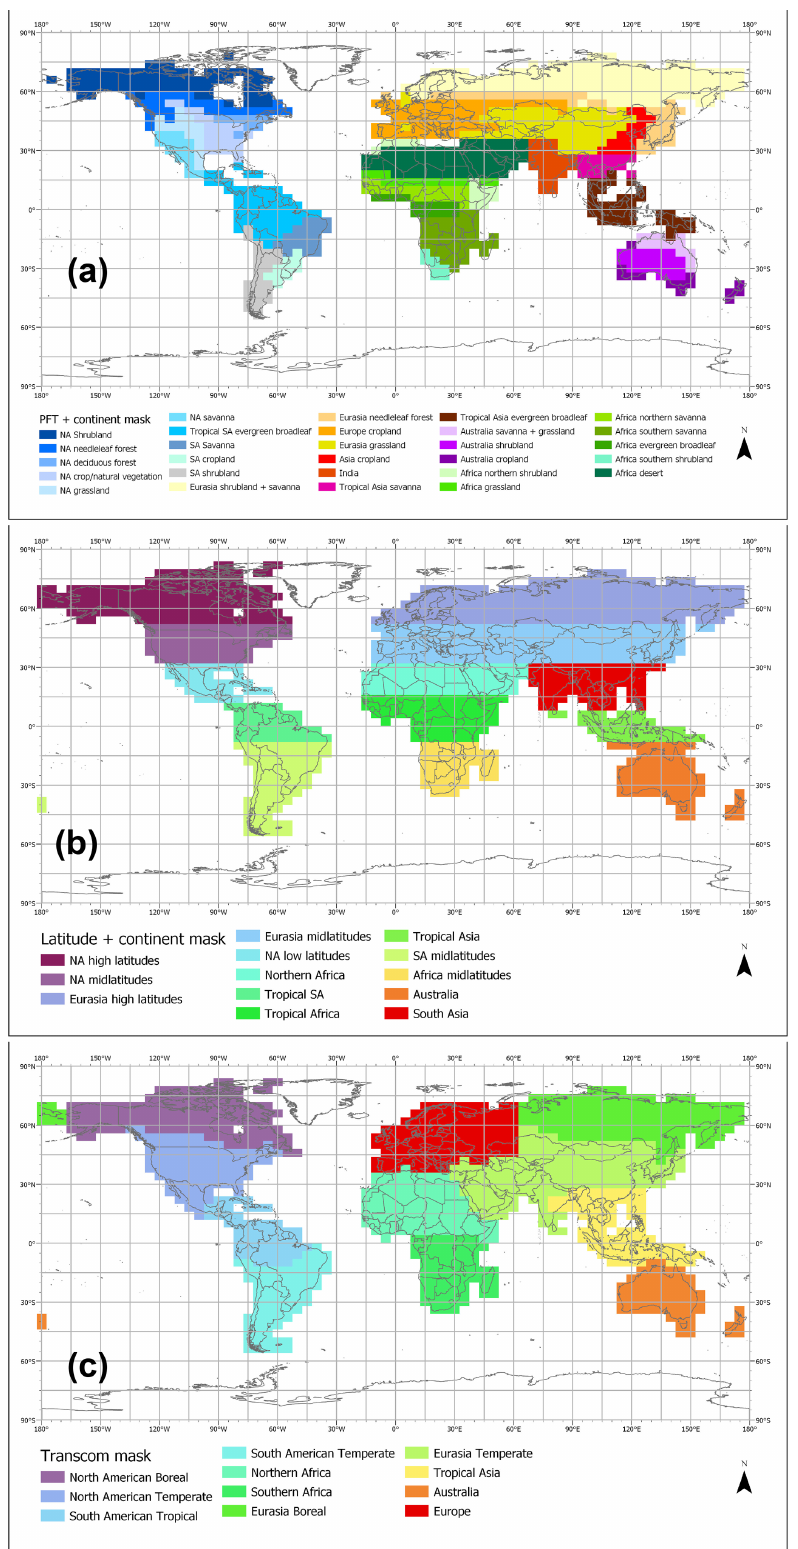
Figure 3. Three types of regional masks used in calculating regional fluxes. (a) The mask is based on a combination of seven condensed MODIS IGBP plant functional types, TransCom 3 regions (Gurney et al., 2004), and continents. (b) The mask is based on latitude and continents. (c) The TransCom region